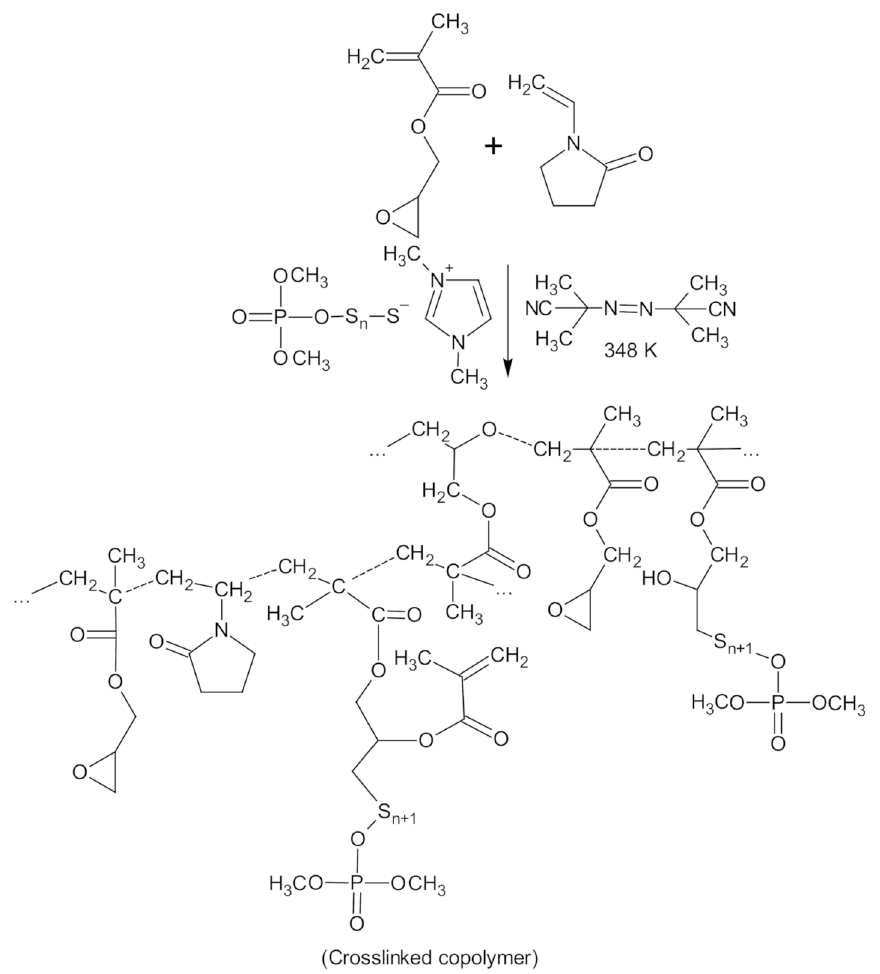
Scheme 3. Polymer network formation during radical copolymerization of VP and GMA initiated by AIBN in the presence of